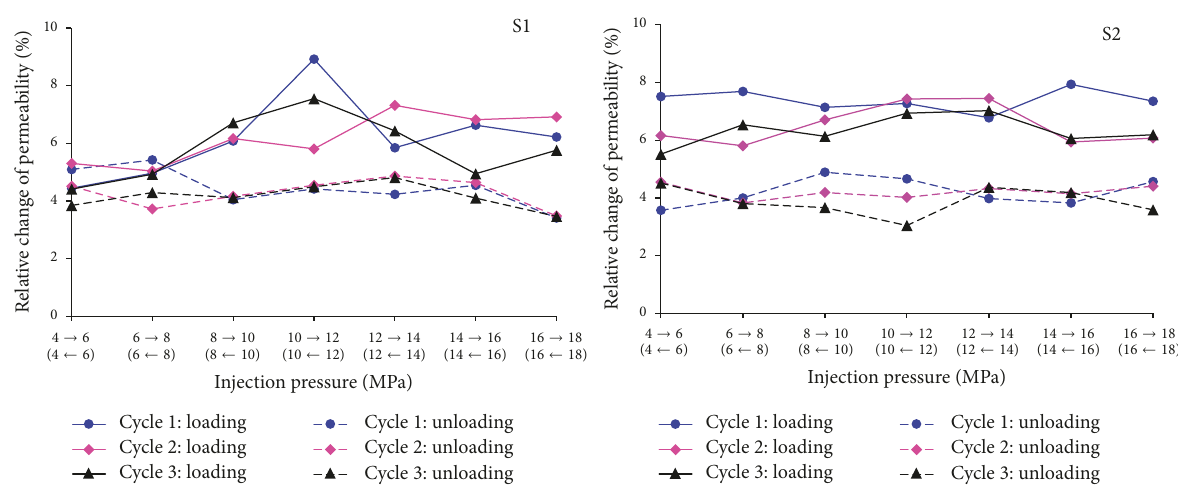
Figure 4: Relative changes in permeability under changing injection pressure